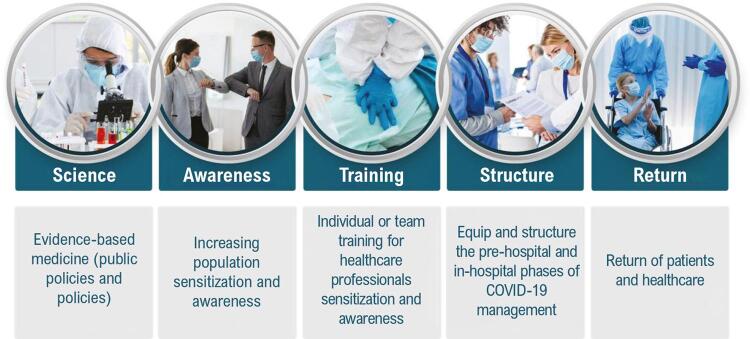
– COVID-19 Chain of Survival.